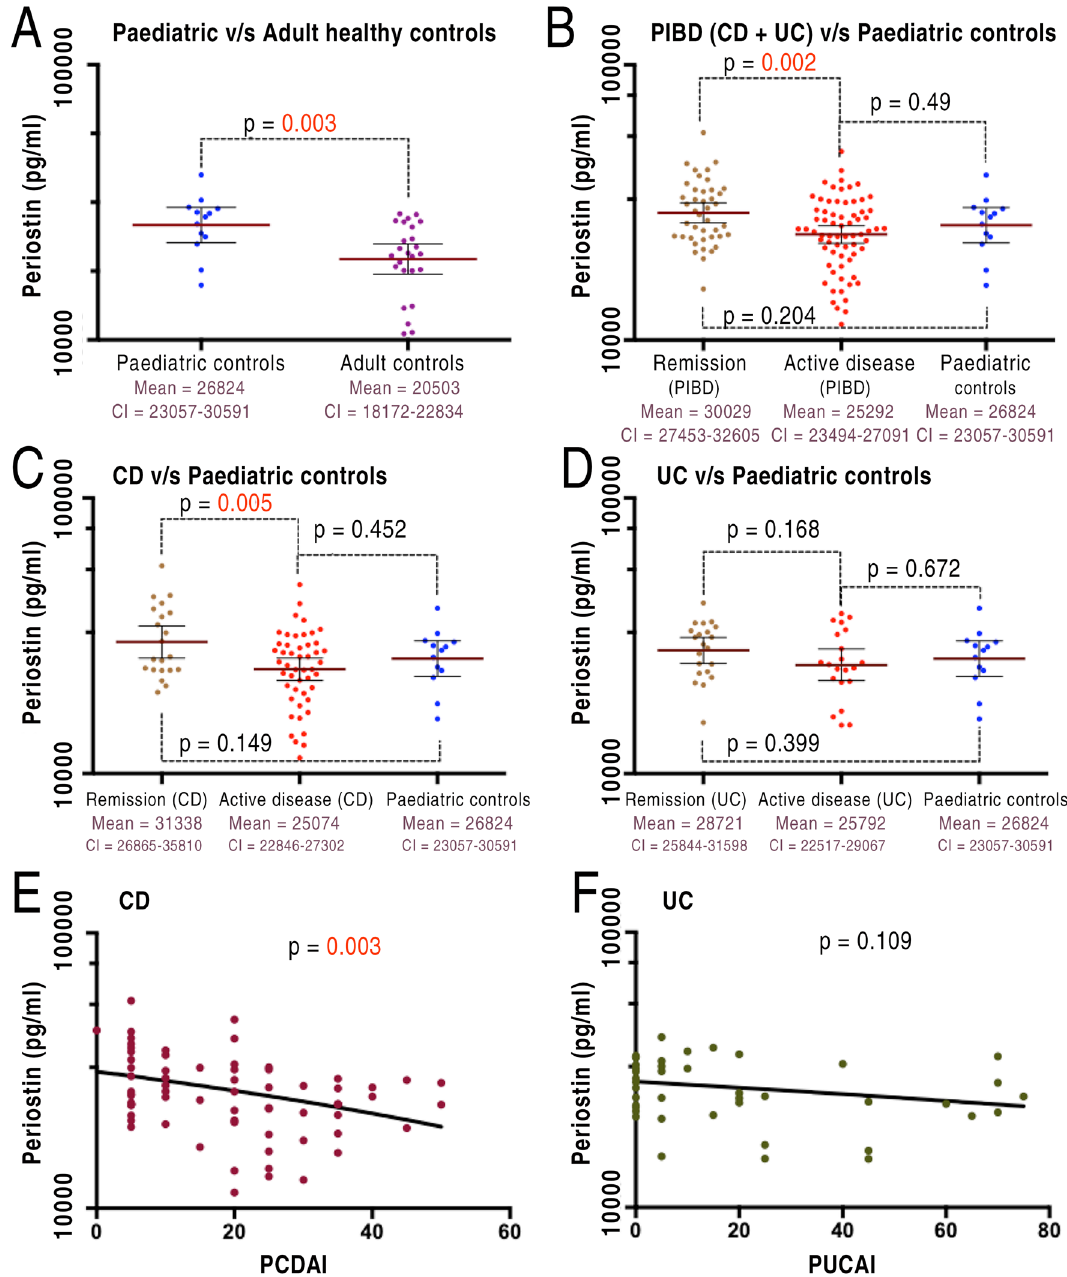
Figure 1. Plasma periostin levels against disease activity. ( A ) Significantly lower levels in adult controls in comparison to paediatric controls ( p = 0.003). ( B ) Higher levels during remission (combined for both CD & UC) than active disease ( p = 0.002). ( C ) Statistically significant differences in periostin levels during remission driven by CD; remission (31,338 ± 2144) compared to active disease (25,074 ± 1108); p = 0.005. ( D ) Patients with UC show no significant differences during remission compared to active disease. ( E ) An inverse relationship between periostin levels and PCDAI scores ( F ) No relationship between periostin and disease activity in UC. This figure was, as also mentioned in the methods/stats section, generated through PRISM https ://www.graph pad.com/scien tific -softw are/prism / Version 7. Abbreviations: CD- Crohn’s disease; PCDAI- paediatric Crohn’s disease activity index; PUCAI- Paediatric ulcerative colitis activity index; pIBD- paediatric inflammatory bowel disease (includes both Crohn’s disease and ulcerative colitis); UC- ulcerative